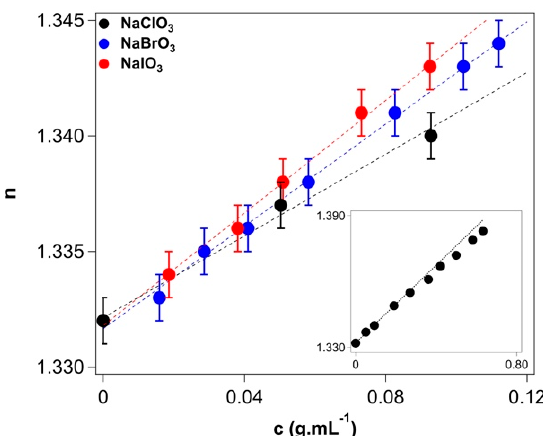
Figure 4. Refractive index values at 20° C as a function of the concentration of sodium chlorate (black), bromate (blue), and iodate (red) solutions. Dotted lines represent the linear fitting according to Equation (A12). The inset shows the measured refractive index for the entire range of concentration for sodium chlorate investigated in this work.